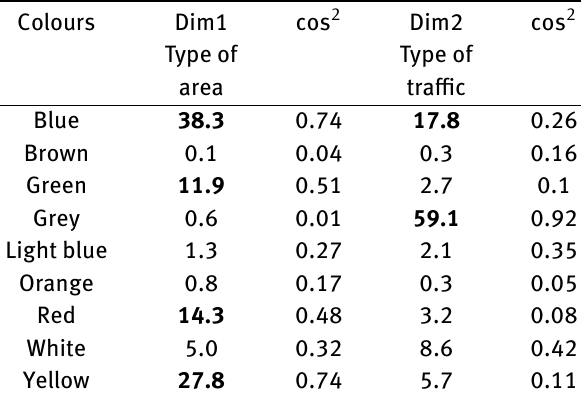
Table 4: Dimension contribution (%) and quality of the columns representation (cos 2 ).